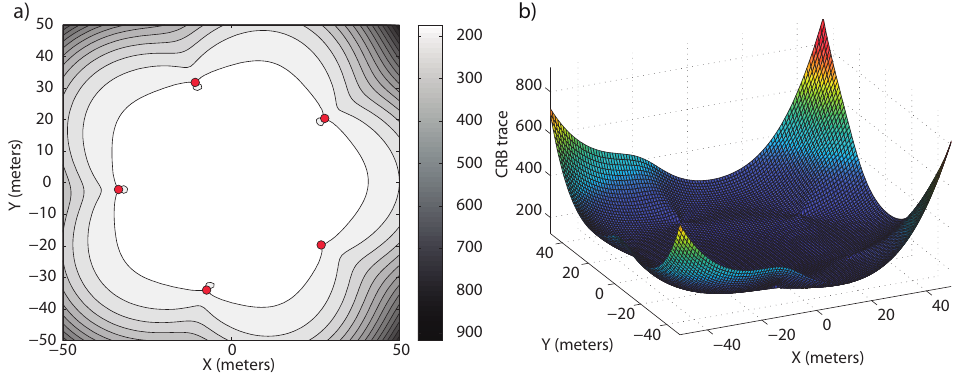
Figure 5. Optimal surface sensor formation for an uncertain target position at a depth of 50 meters, σ = 0 . 05 rad and η = 0 . 05 . In ( a ) the level curves of tr ( CRB ) D in ℜ 2 are shown and in ( b ), its magnitude in 3D for D .